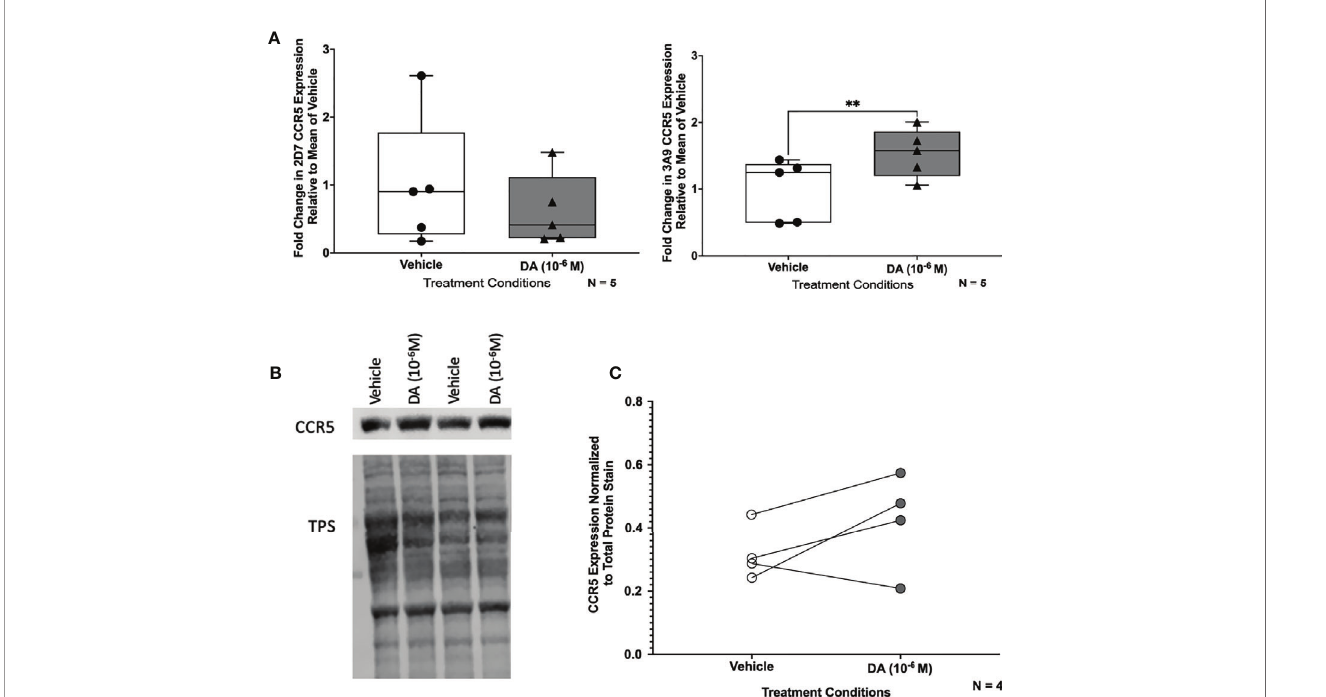
FIGURE 8 | Dopamine increases NT CCR5 in C06 human microglia. (A) Change in CCR5 expression relative to the mean of vehicle-treated (diH 2 O) C06 cells demonstrates that dopamine increases NT but not ECL2 CCR5, similar to what we found in hMDM (N=5) (ECL2 CCR5, Paired t-test, n=5, Dopamine, p=0.1818, t=1.614, df=4; NT CCR5, Paired t-test, n=5, Dopamine, **p=0.0043, t=5.837, df=4). C06 cells were also treated with dopamine (10 -6 M) for 1 hour and probed for pan NT CCR5. A representative blot is shown in (B). (C) Pooled data showing fold change in C06 cells from 4 passages relative to the vehicle condition is shown with CCR5 normalized to total protein stain. Although this did not reach signi fi cance (Paired t-test, n=4, Dopamine, p=0.2182, t=1.553, df=3), three out of four passages show an increase in NT CCR5 with dopamine relative to